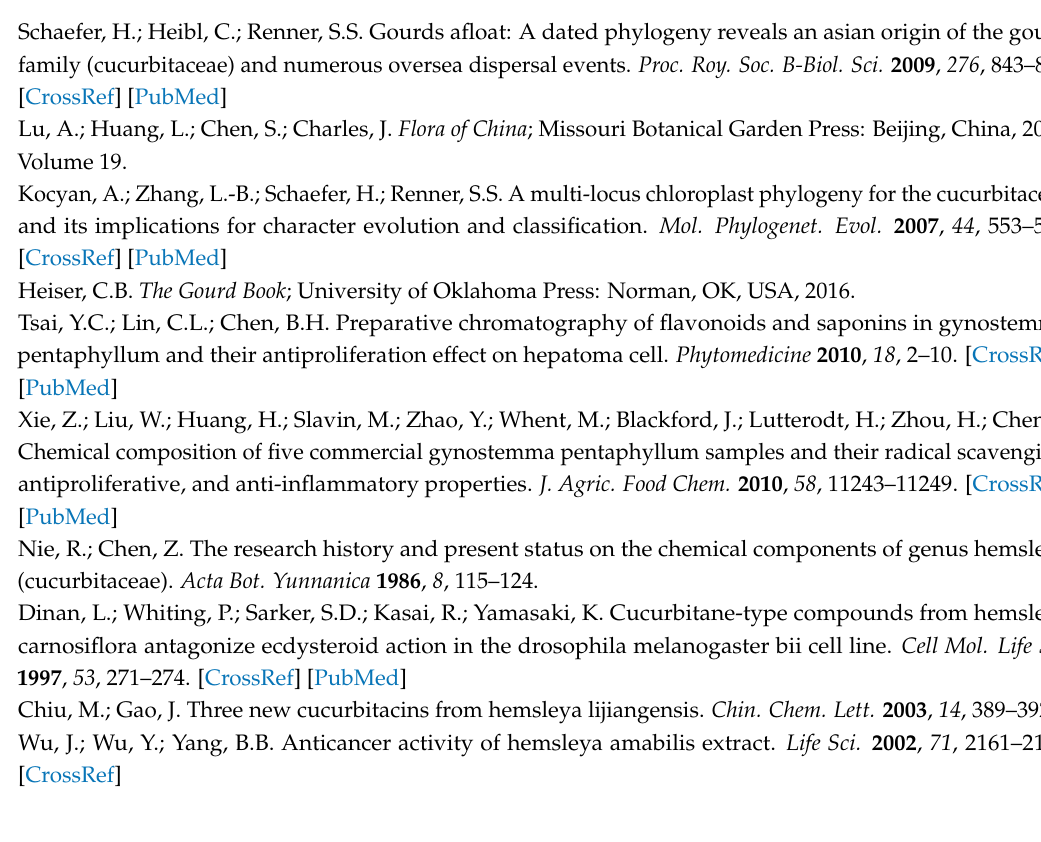
Supplementary Materials: The following are available online. Figure S1. Genome rearrangement events of 10 Cucurbitaceae species, comparing with C. laevigata and N. tabacum ; Figure S2. Sequence identity plots among 11 chloroplast genomes, with G. cissiformis var. cissiformis as a reference by using mVISTA. The vertical scale indicates the identity percentage ranging from 50% to 100%. The horizontal axis corresponds to the coordinates within the chloroplast genome. Coding and non-coding regions are marked in blue and pink, respectively. Annotated genes are displayed along the top. The black boxes show the two IR regions; Figure S3. Amino acid frequencies and base compositions of chloroplast genomes of four species. (A) Frequency of amino acids usage; (B) Base compositions of chloroplast genomes; Figure S4. Phylogenetic relationship of the 27 species inferred from ML and BI analyses based on four datasets (A. LSC; B. SSC; C. IR; D. CDS; E. 8 HVR). The bootstrap values of ML analyses and Bayesian posterior probabilities are shown beside the clades. C. laevigata and N. tabacum were used as the outgroups; Table S1. Primers for low coverage regions of Cucurbitaceae species; Table S2. List of species and their basic information included in the analyses of complete chloroplast genomes; Table S3. Percentages of variable characters in coding and non-coding regions and the percentage of indels in variable characters; Table S4. PCR primers for relatively highly variable regions; Table S5. List of tandem repeats in the chloroplast genome of eleven Cucurbitales species; Table S6. List of dispersed repeats and palindromic repeats in the chloroplast genome of eleven Cucurbitales species; Table S7. List of SSRs in the chloroplast genome of eleven Cucurbitales species; Table S8. Summary of three categories of repeats and simple sequence repeats (SSRs); Table S9. Results of selective events analysis in KaKs-calculator; Table S10. Codon usage and relative synonymous codon usage (RSCU) value for protein-coding genes in the ten Cucurbitaceae chloroplast genomes; Table S11. Base compositions for protein-coding genes in the ten Cucurbitaceae chloroplast